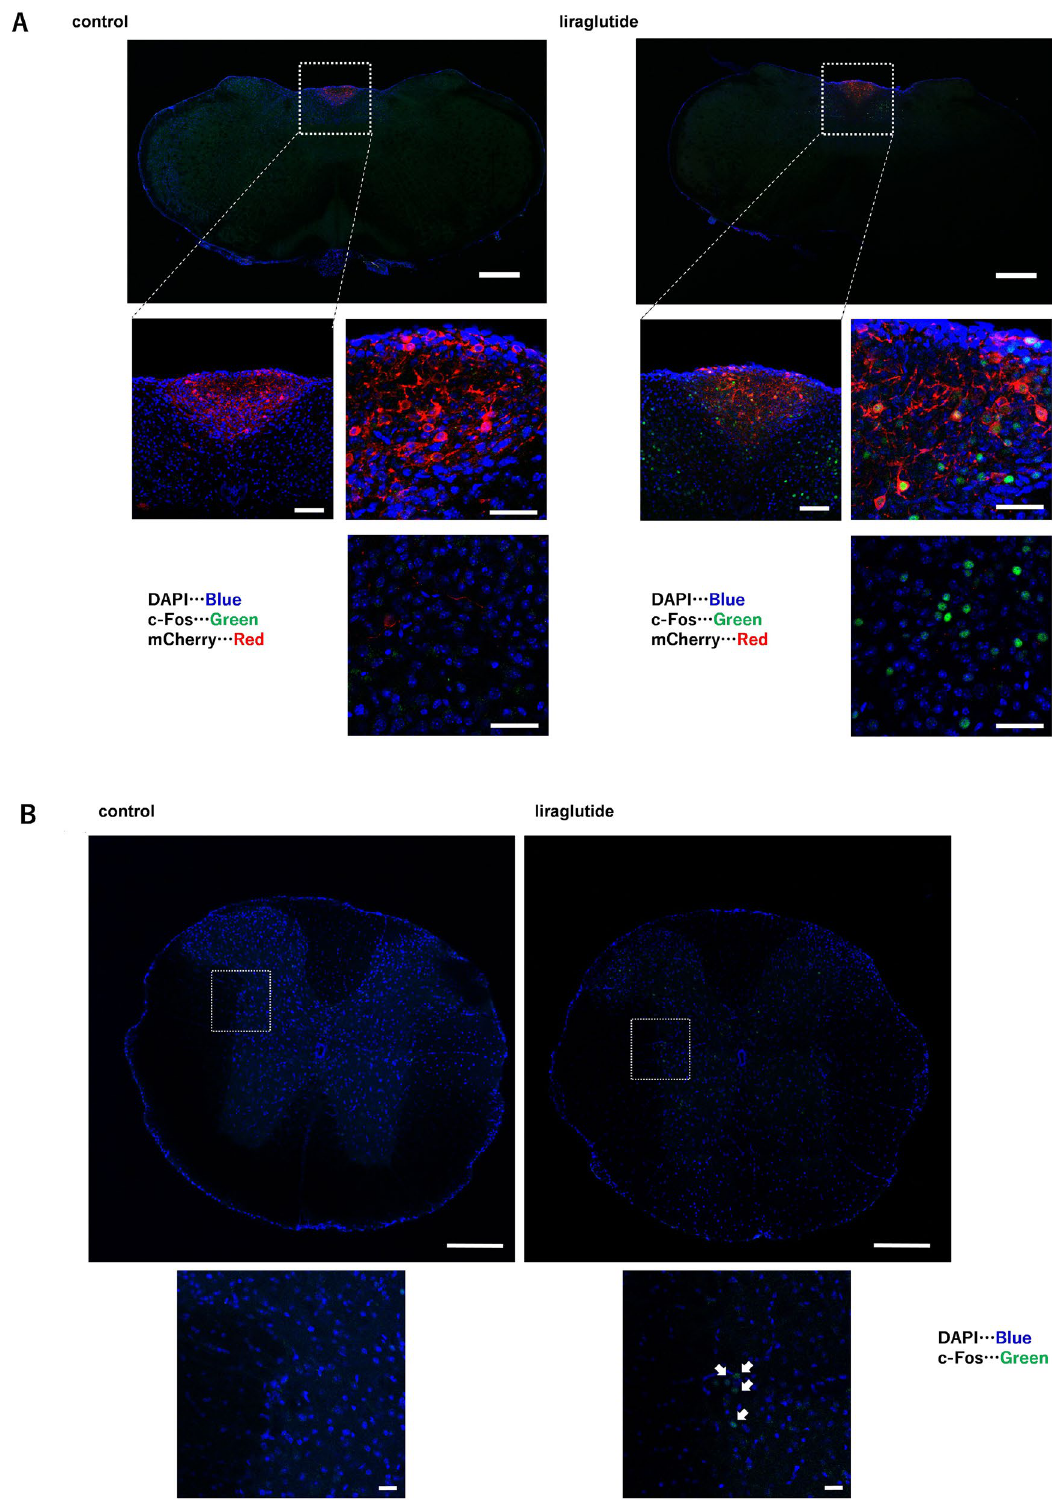
Figure 4. Liraglutide enhances c-Fos staining, not only in the AP/NTS, but also in the IML. Representative image of immunohistochemistry for c-Fos in ( A ) the AP and NTS and ( B ) the IML with or without acute liraglutide administration. In ( A ), the top and middle left images are the original magnification, whereas the middle right and lower images are the original magnification × 40. Scale bars: 500 µm in the top image, 100 µm in the middle left image, and 50 µm in the middle right and lower images in ( A ). All images are the original magnification in ( B ). Scale bars: 200 µm in the top image, 20 µm in the lower image in ( B ). Arrows indicate c-Fos staining in ( B